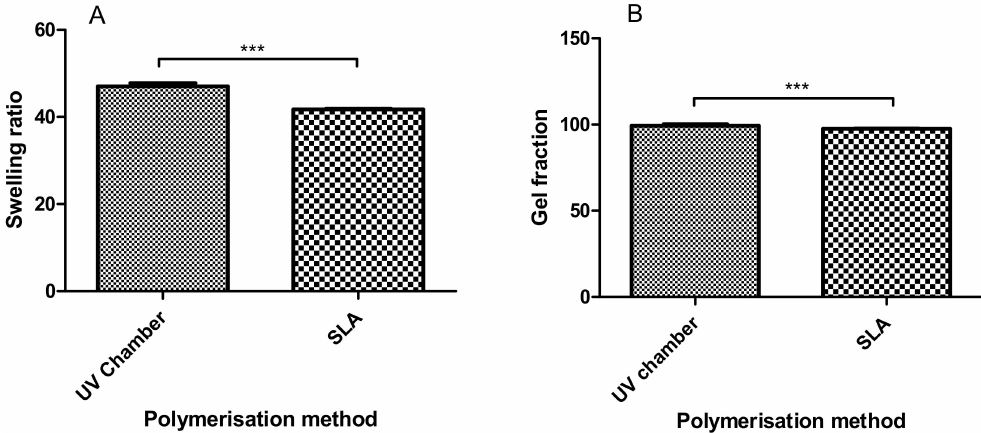
Figure 1. Comparison between ( A ) the swelling characteristics and ( B ) the equilibrium water content of the UV chamber-polymerised polyethyleneglycol dimethacrylate (PEGDMA) hydrogels and the stereolithography (SLA)-polymerised PEGDMA hydrogel.